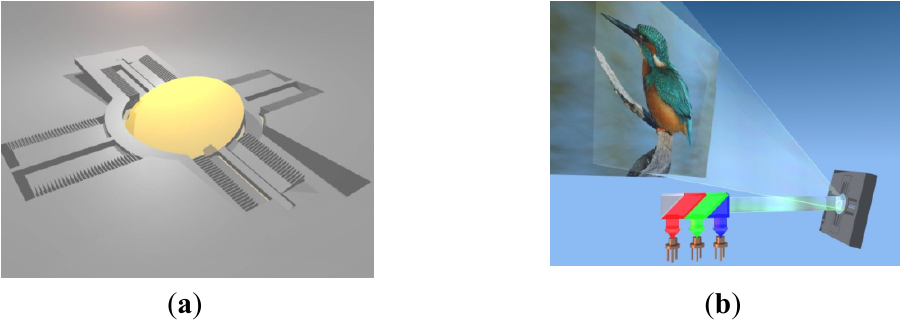
Figure 1. ( a ) Gimbal mounted biaxial MEMS scanning mirror electrostatically actuated by stacked vertical comb drives; ( b ) Biaxial MEMS scanning mirror in a laser projection display.